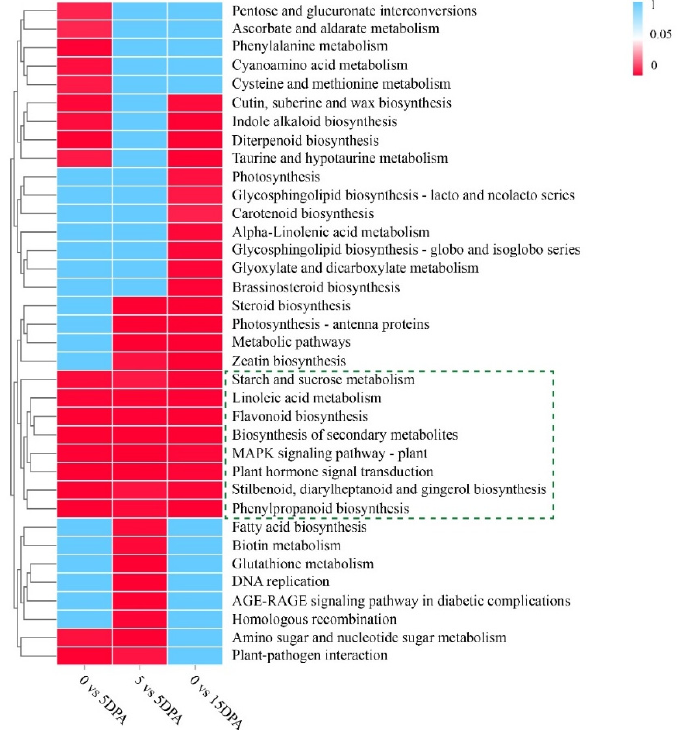
Figure 2. KEGG enrichment analysis of DEGs under three different comparisons. The significant p -values of each KEGG term under different comparisons are shown with a heat map. The green box indicates that the metabolic pathway was significantly changed between different developmental stages.